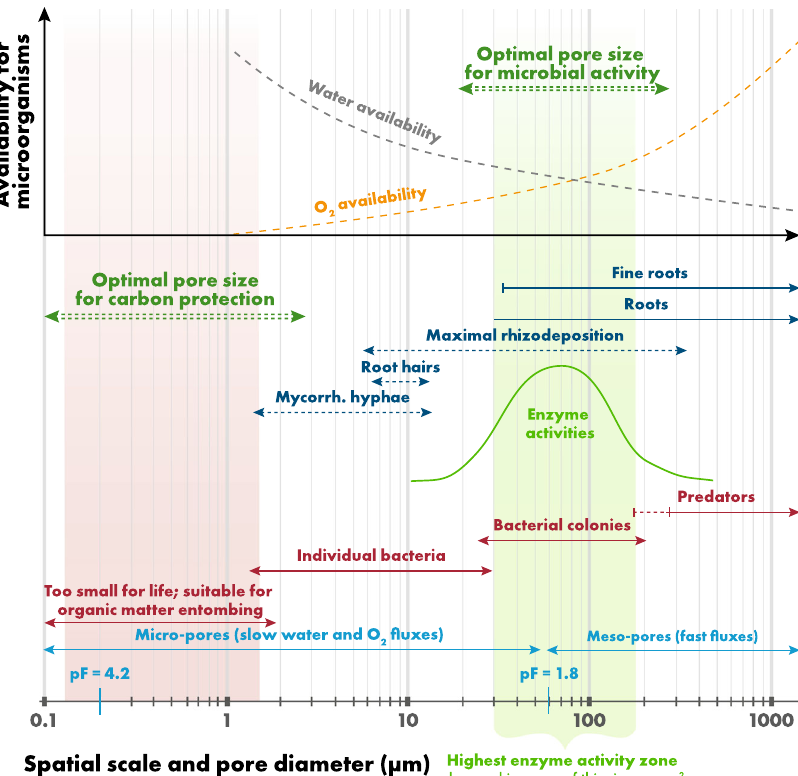
Fig. 1 Intra-pore environmental conditions related to biological and enzyme activities as a function of pore size. Water and gas fl uxes are very slow in few-micron-sized pores, increasing rapidly with increasing pore size (blue lines and text). Pores <1 µ m diameter are too small for hosting microorganisms, and only single bacteria cells or fungal hyphae can be hosted within <10 µ m pores. Pores with 10 to few-hundred- µ m diameters accommodate fi ne plant roots and root hairs and are the locations of maximal rhizodeposition. This pore range is optimal for microorganisms due to plant inputs, and optimal water and O 2 availabilities (top graph). This is the range of pores with the highest enzyme activities elucidated by zymography and µ CT 2 results of our study (shaded green). The pores of larger size are occupied by predators decreasing microbial density by grazing. Carbon sequestration is mainly taking place in the pores smaller than few micrometers by entombing: spatial exclusion from microbial and enzymatic activities (shaded